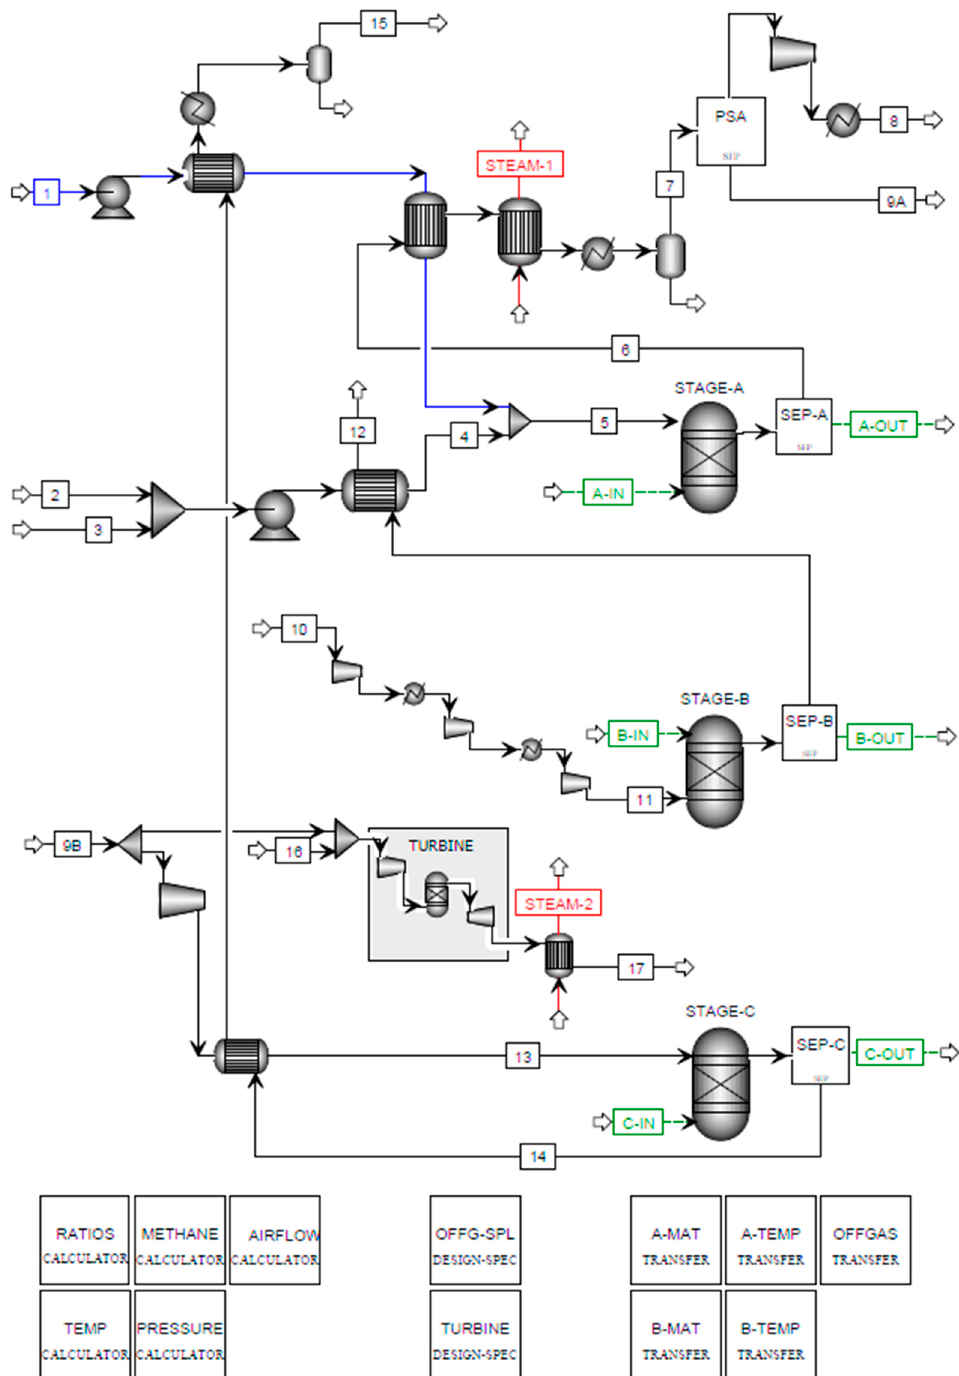
Figure 4. Aspen Plus flowsheet for SE-CLSR of bio-oil.